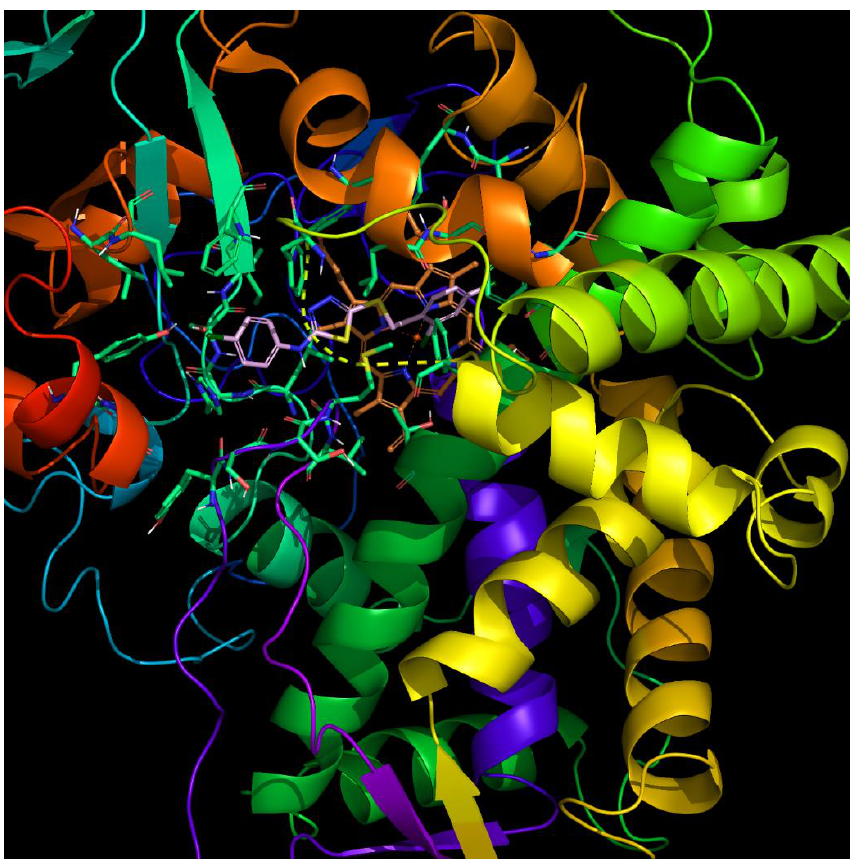
Figure 5. The interacting mode of compound 3k in the active region of 14- α -sterol demethylase (PDB code: 5FSA). The inhibitor is colored purple, and the heme molecule is colored orange.